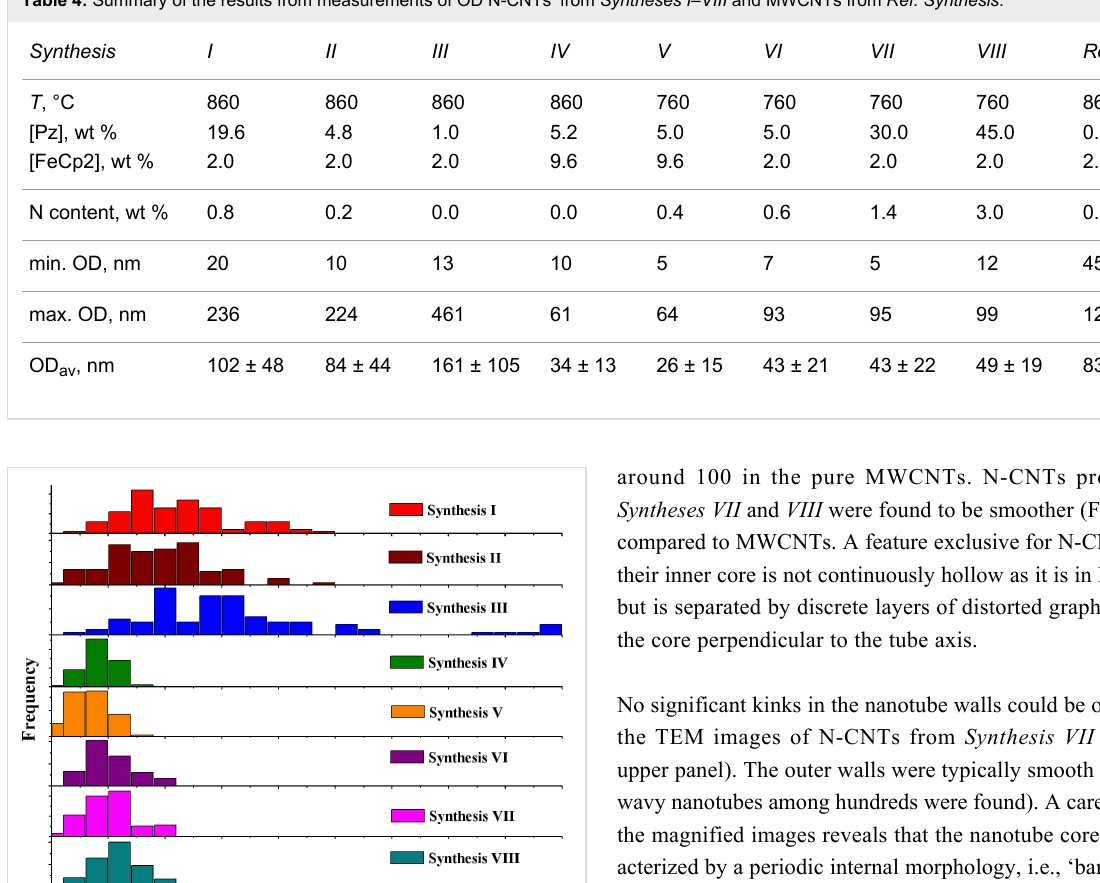
narrowed down when increasing [FeCp 2 ] in the feedstock and decreasing the